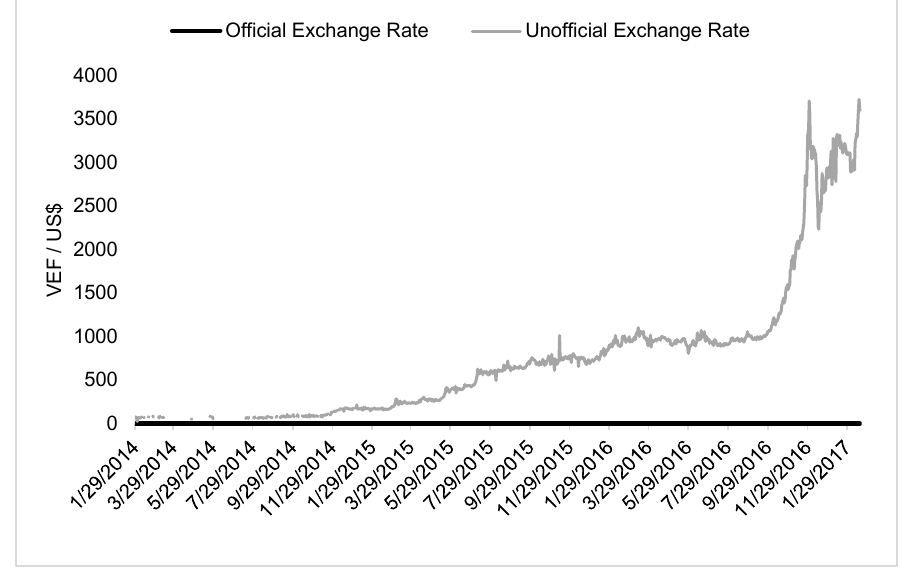
Fig. 2. Venezuelan official and unofficial exchange rates from January 2014 to 17 February 2017 when the official exchange rate is set at 6.3 VEF/US$. Fig. 3 is the period covering the official exchange rate of 10 VEF/US$ with the unofficial rate climbing from 3,634 to 793,787 VEF/US$. The spike on 15 February 2018 is a large purchase of bitcoins at twice the going market rate.